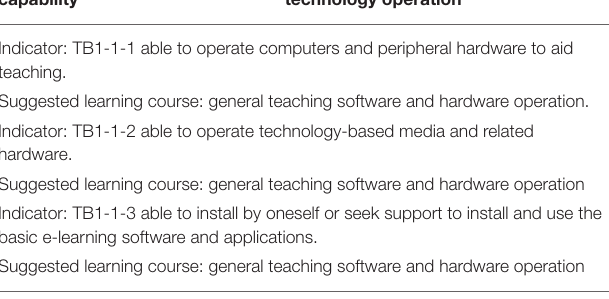
Sub-level: TB1-1 basic information technology